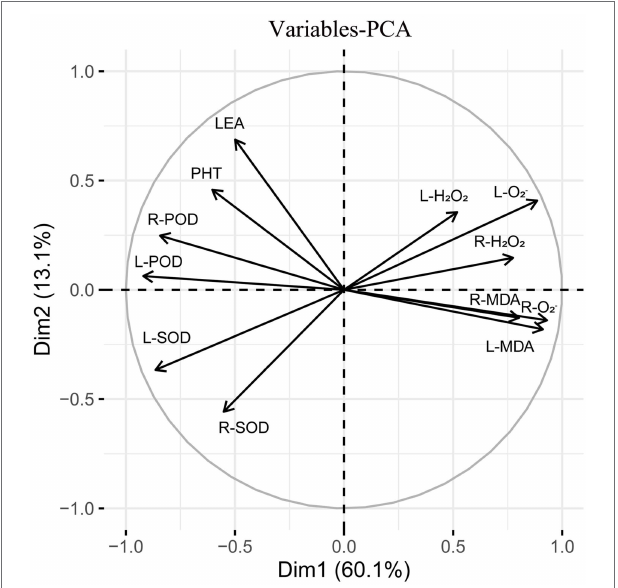
FIGURE 12 | Principal component analysis of 13 indexes (morphology and physiology) in triticale